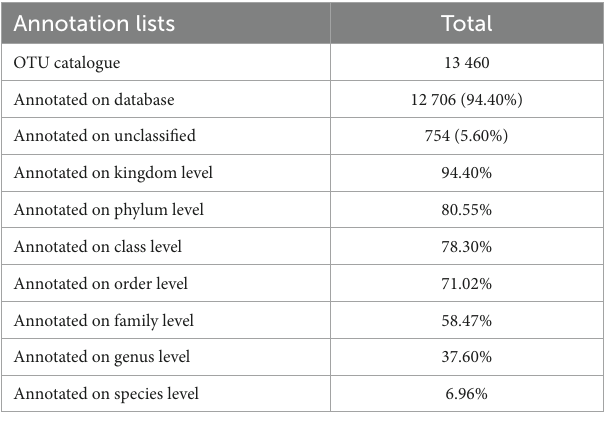
TABLE 1 Summary statistics of annotated